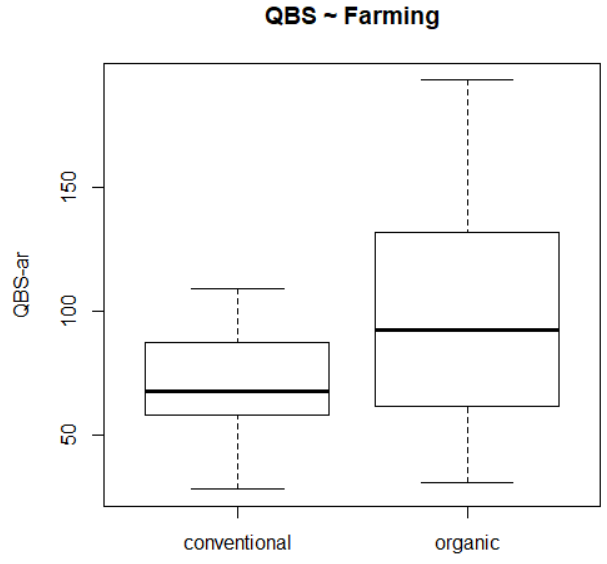
Figure 3. Boxplot of QBS-ar distribution according to farming system.